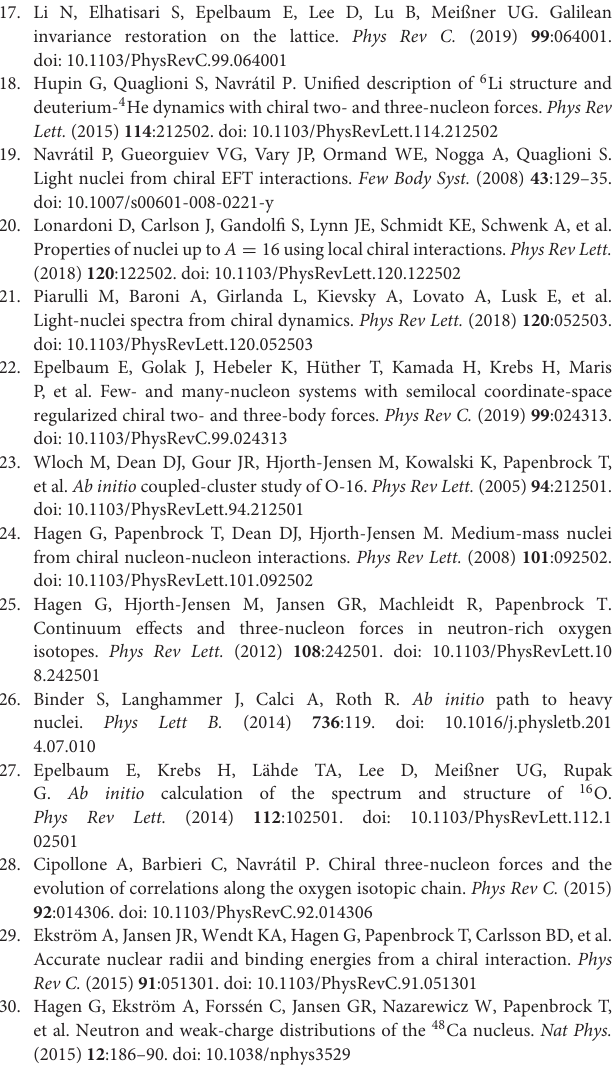
Figure S3 | Phase diagram of nuclear matter at zero temperature. λ controls the strength of the local part of the interactions. Figure from Elhatisari et al. [11]. Figure S4 | Calculated binding energies from 3 H to 48 Ca. The solid symbols are lattice results and the open symbols are experimental values. The experimental values are from Wang et al. [14]. Figure adapted from Lu et al. [12]. Figure S5 | Computed 16 O and 40 Ca charge densities compared with experimental results. The circles denote the results without Coulomb interaction. The squares are the results with the Coulomb interaction included perturbatively. Experimental results are from De Vries et al. [15]. Figure adapted from Lu et al. [12]. Figure S6 | Ground state energy of pure neutron matter as a function of neutron density for box sizes L = 5 (upright triangles), L = 6 (squares), L = 7 (right-pointing triangles). The filled red polygons are results for the leading-order interaction. The open red polygons show an improved calculation with a short-range interaction tuned to the physical neutron-neutron scattering length as well as a correction to restore Galilean invariance. Also shown are results calculated with N 3 LO chiral interactions (EM 500 MeV, EGM 450/500 MeV and EGM 450/700 MeV) [37], as well as results from variational (APR) [38] and auxiliary-field diffusion MC calculations (GCR) [39]. Figure adapted from Lu et al.